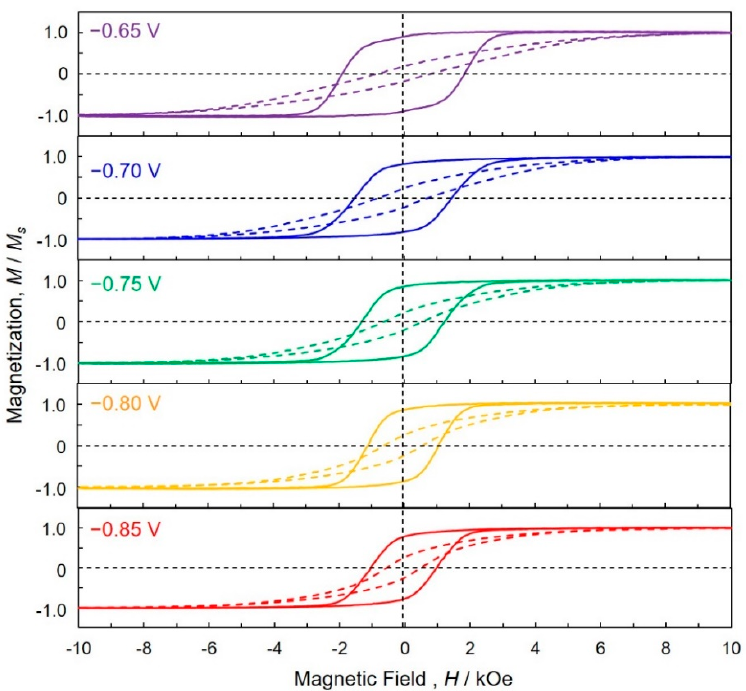
Figure 10. Magnetic hysteresis loops of Co nanowire arrays that were electrodeposited at each cathode potential ranging from − 0.65 V to − 0.85 V in the anodized aluminum oxide (AAO) nanochannel films. Magnetic field was applied to the in-plane (dashed lines) and perpendicular (solid lines) directions, with respect to the films.